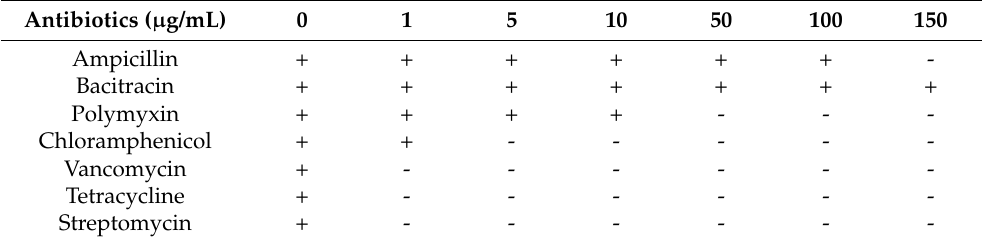
Table 4. Antimicrobial susceptibility test of P. mucilaginosus